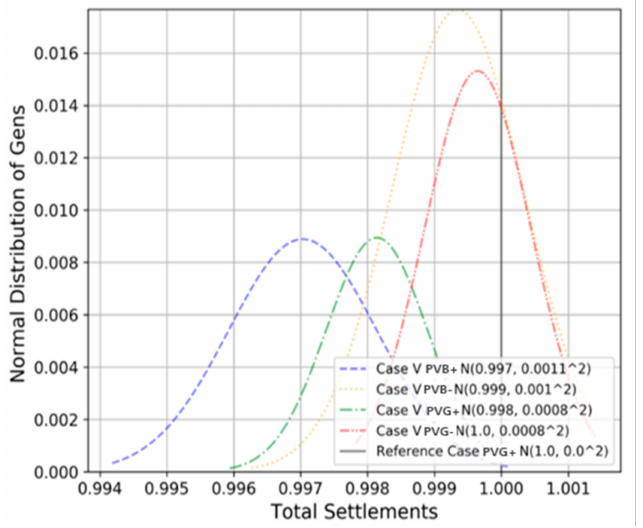
Figure 10. Distribution of PVs revenue in each group under Case V. The average revenue of each WT group (WTB+, WTB-, WTG+, and WTG-) in each case is shown in Figure 11. The relative revenue in each case is denoted based on KRW 3691 million (approximately USD 3.1 million), which is the settlement of WT in the reference case. The WT group’s revenue trend in each case shows a similar trend to that of PV groups. However, because it is assumed that the prediction accuracy of the WT groups is higher than that of PVs, the effect of the imbalance on revenue is less; thus, the revenues are closer to 1.